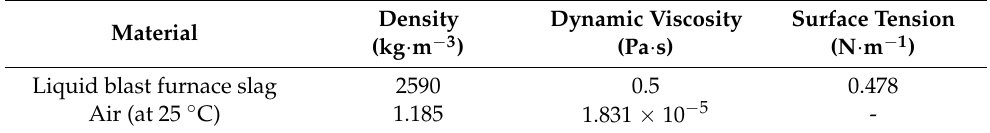
Figure 2. Three-dimensional illustration of the computation domain defined in the present CFD model for simulating slag film breakup into droplets. 1, 2, 3, and 4: pressure outlets; 5: slag inlet; 6: upper face of the solidified slag tip; 7: lower face of the solidified slag tip; 8: the solidified slag tip; 9: inner face of the spinning cup sidewall; 10: angle between the spinning cup sidewall and horizontal plane. Table 1. Properties of liquid blast furnace slag and air used in the present CFD model